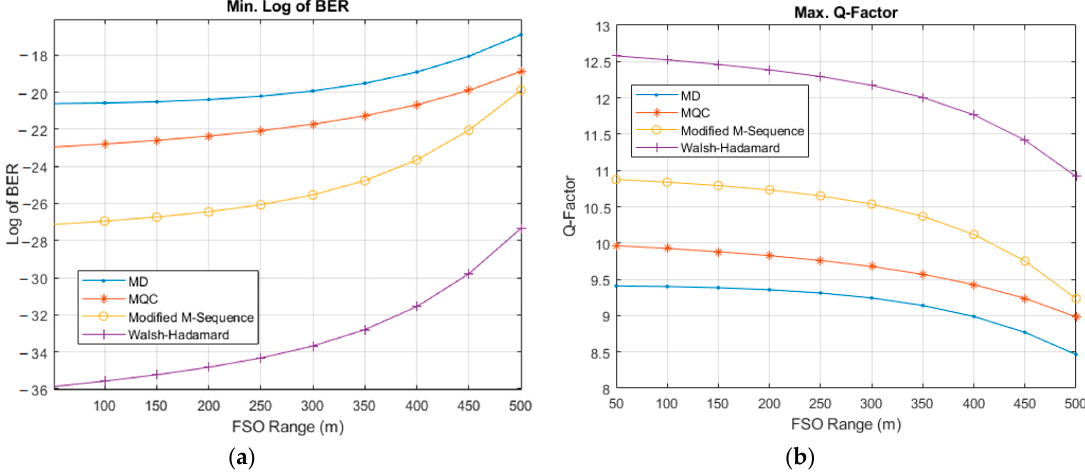
Figure 16. Performance of the system under intense turbulence condition: ( a ). min. log of BER; ( b ). max. Q ‐ factor.